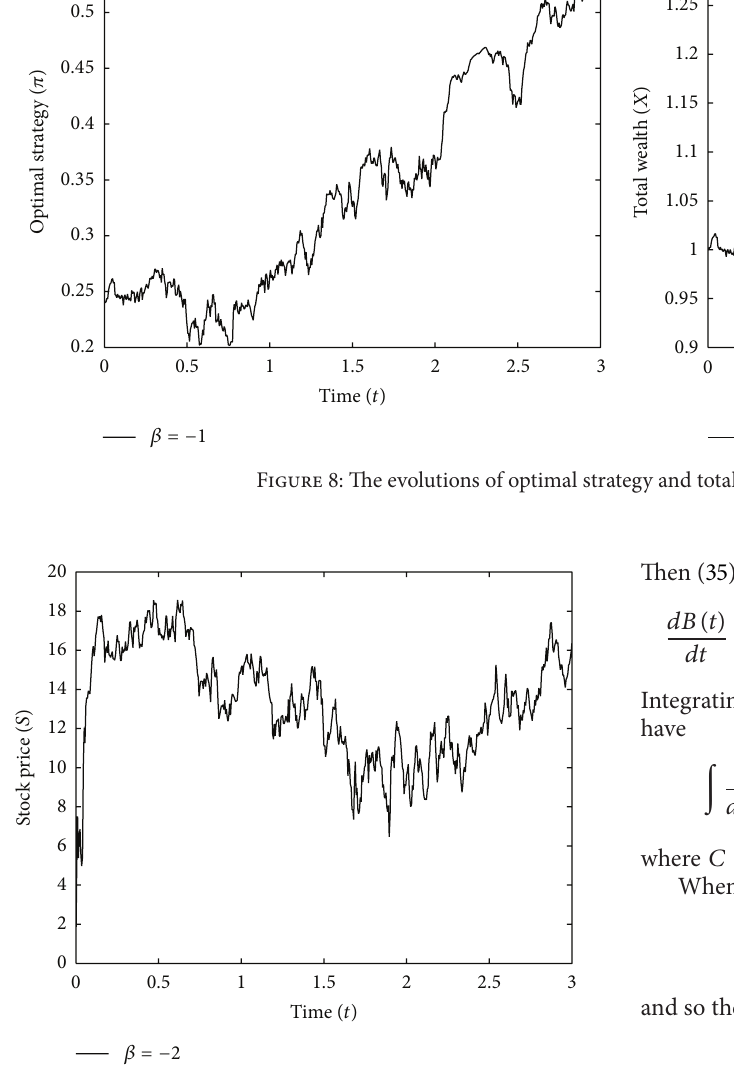
Figure 9: The evolution of stock price over time ( 𝛽 = −2